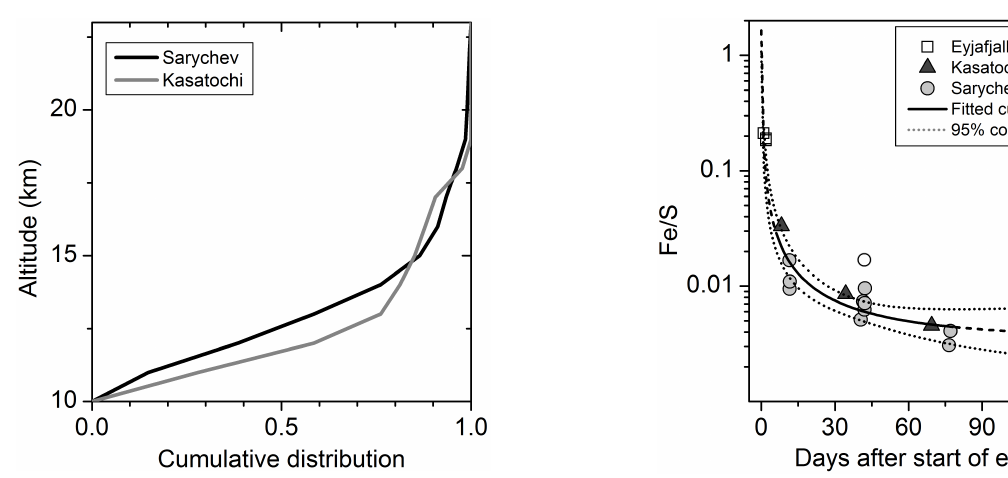
Fig. 6. Cumulative altitude distributions of volcanic injections above 10km the first week after the Sarychev and Kasatochi erup- tions. The distributions was deduced from the number of observa- tions of volcanic aerosol layers in CALIPSO lidar measurements as a function of altitude, see the text for further details.